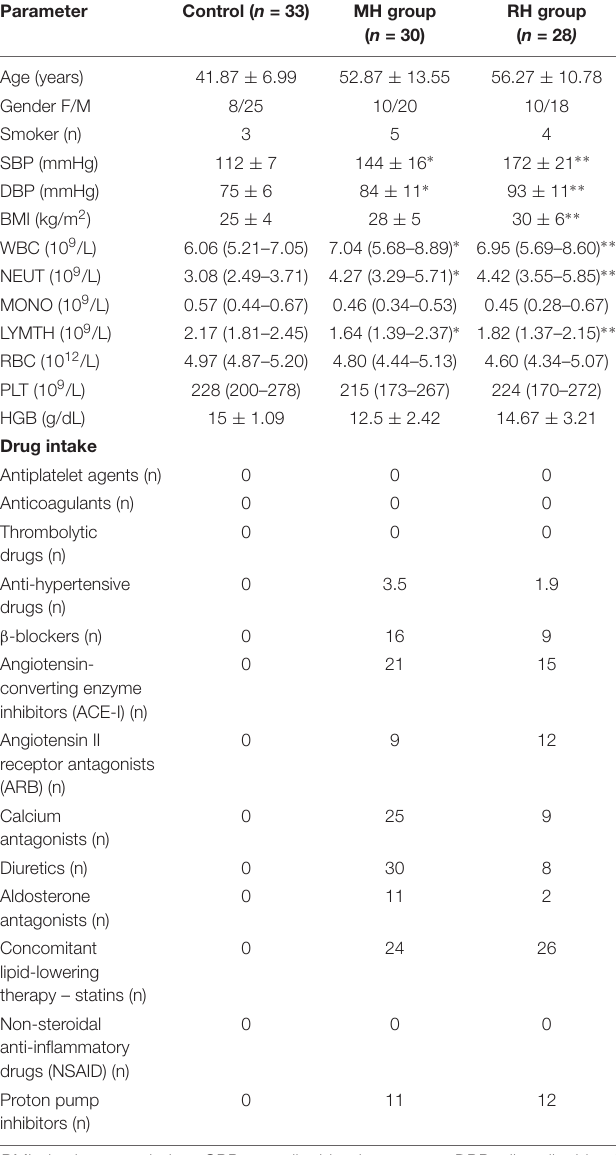
TABLE 1 | Clinical baseline characteristics of the study